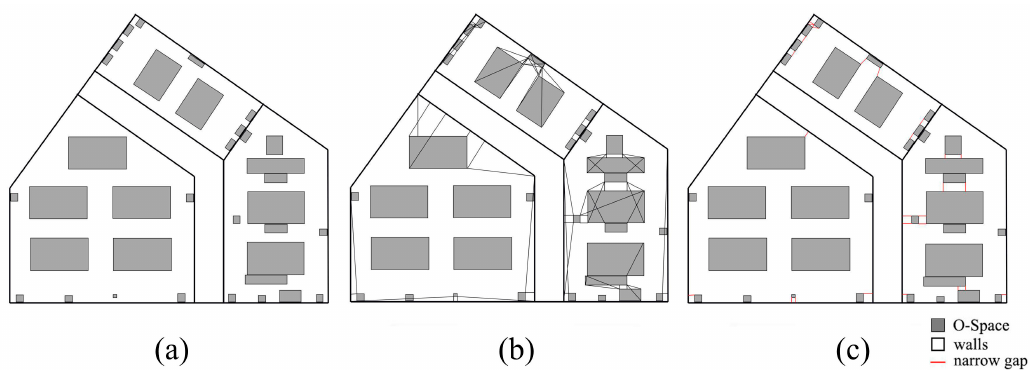
Figure 13. The generation of narrow gaps for a non-disabled adult male. ( a ) The projection of the experimental environment. ( b ) The MDs between each 𝐼𝑂 and every 𝐼𝑂 in its buffer. ( c ) The narrow gaps of the experimental environment.